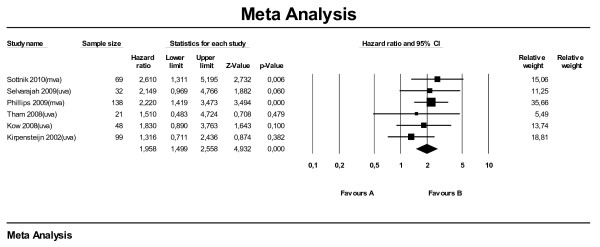
Meta-analysis of univariate and multivariate data sets for predictive value of serum alkaline phosphatase level on median disease free interval using hazard ratios.